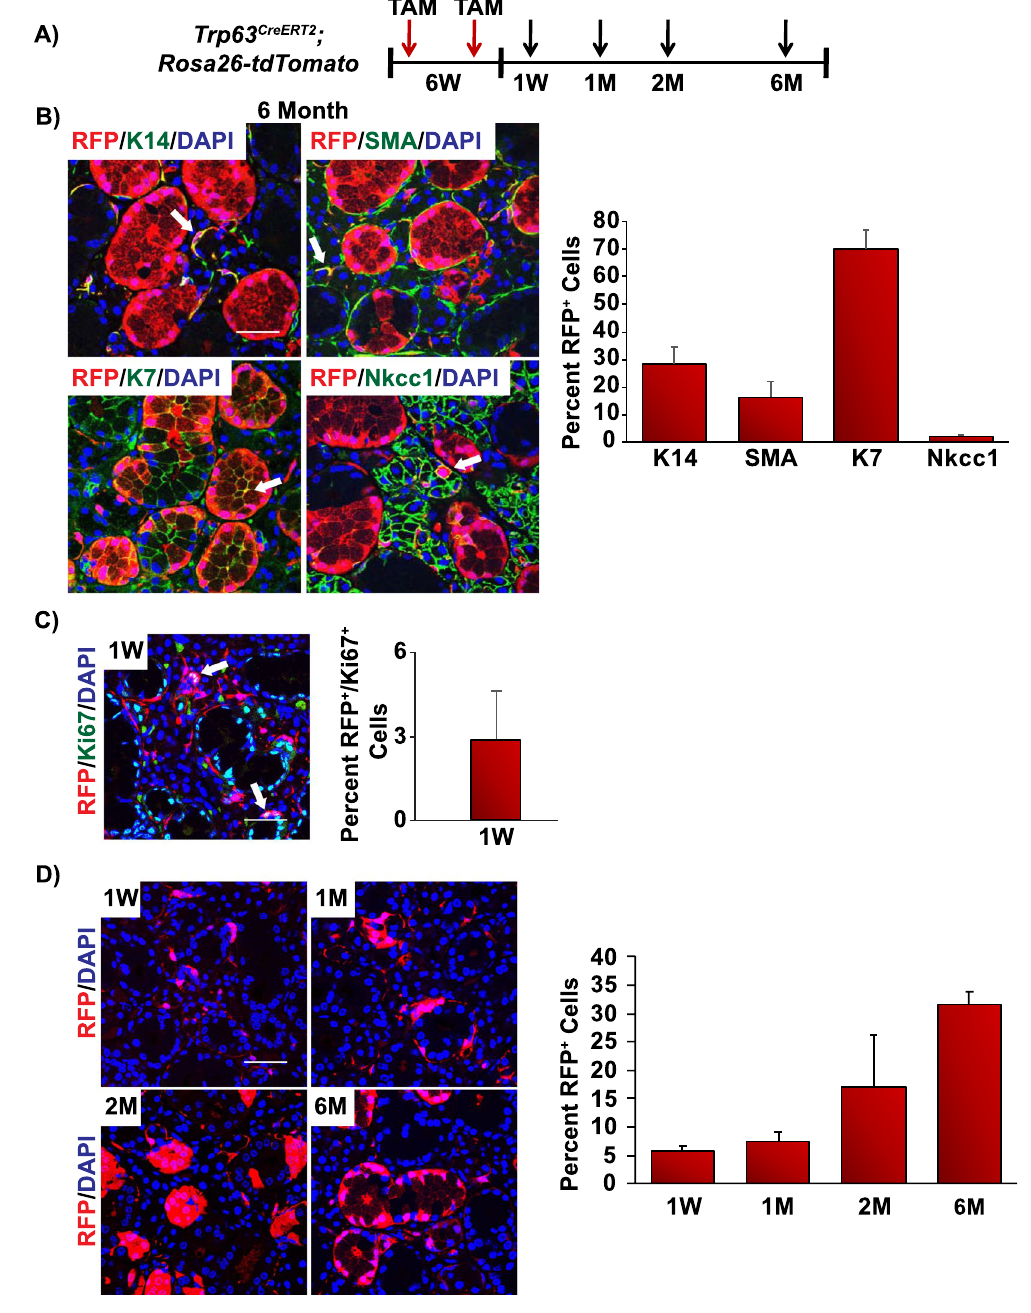
Figure 6. p63 + cells maintain the mature cell lineages of the submandibular gland. ( A ) Experimental timeline used for the genetic lineage tracing experiments in adult Trp63 CreERT2 ;Rosa26-tdTomato mice. RFP expression was induced by TAM injection in 6-week old adult mice and cells were traced for 1 week and 1, 2 and 6 months. ( B ) RFP expression was detected in all the epithelial cell lineages which comprise the salivary gland in Trp63 CreERT2 ;Rosa26-tdTomato mice at 6 months (left panel). Quantification of the percentage of RFP + cells which co-express the various cell lineage markers as indicated (right panel). ( C ) Co-staining of RFP and the proliferative marker Ki67 in adult submandibular glands 1 week after TAM administration (left panel). Quantification of RFP + /Ki67 + cells in submandibular glands, expressed as a percentage of total single Ki67 + cells (right panel). ( D ) Submandibular glands were evaluated for RFP expression 1 week and 1, 2 and 6 months following TAM administration (left panel). Quantification of RFP + cells per total number of cells (nuclei) counted in glands isolated at the indicated time points after TAM administration (right panel). Data are represented as mean ± standard deviation (S.D.). Arrows highlight double positive cells as indicated. W- week, M- month. Scale bar 37 μ m. n = 4